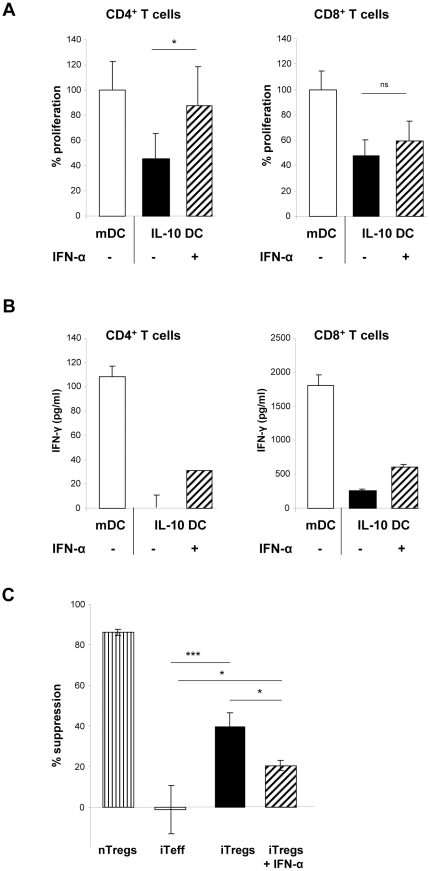
IFN-α treatment of IL-10 DC abolished suppressor function of iTregs.(A, B) CD4+ or CD8+ T cells were cultured in primary culture with allogeneic mDC, IL-10 DC or IL-10 DC treated with 104 U/mL IFN-α, respectively. Restimulation experiments were performed with anti-CD3/anti-CD28. T cell proliferation is depicted in % (normalized to 100% proliferation induced by mDC). Mean values +/− SD of 4 (CD4+) or 3 (CD8+ T cells) independent experiments are shown. (B) Supernatants were obtained after 72 h and analyzed for IFN-γ production by ELISA. One representative experiment is demonstrated for CD4+ and CD8+ T cells, respectively. (C) Suppressor assay: CD4+ T cells primed with allogeneic mDC (iTeff), IL-10 DC (iTregs) or IL-10 DC treated with 104 U/mL IFN-α (iTregs + IFN-α), respectively, or freshly isolated CD4+CD25high nTregs were cocultured with CD4+CD25low effector T cells and stimulated by 0.5 µg/mL anti-CD3 in the presence of irradiated PBMC. T cell proliferation was determined by [3H] thymidine incorporation. Suppressor activity is shown in proliferation of Teff + cocultured T cell population/poliferation of Teff ×100 in % +/− SD. One representative experiment of 3 is demonstrated. Results are shown in absolute cpm +/− SD for triplicates. * p<0.05; ** p<0.01; *** p<0.001, n.s. not significant.